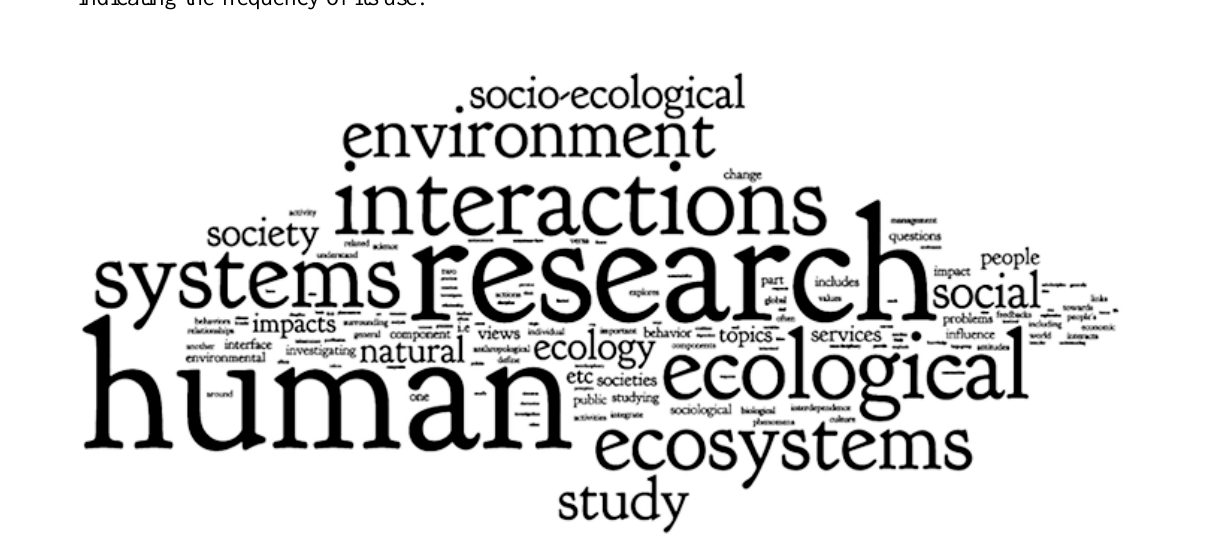
Fig. 2 . A visual representation of the most frequent terms Long Term Ecological Research (LTER) graduate students used when asked to define social-ecological research, with the size of the word indicating the frequency of its